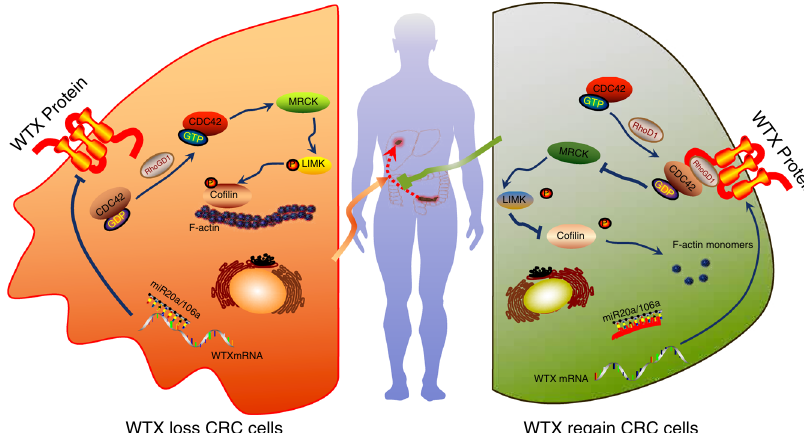
Fig. 7 The mechanism of Mir20a/106a-WTX axis regulates RhoGDI/CDC42 signaling and their function in CRC progression. In CRC cell, the aberrant high miR-20a/106a inhibits WTX expression. Without WTX, RhoGDI α could not form the stable RhoGDI α /CDC42 complex, subsequently the CDC42 GDP dissociats from RhoGDI α and transforms to CDC42 GTP and becomes active. Then CDC42 GTP activates the downstream MRCKa-LIMK1/2-Co fi lin pathway, which results in F-actin remodeling, increased cell proliferation, polarity, and migration ability, fi nally promots CRC progression and liver metastasis. To block miR-20a/106a could recover WTX expression. The regained WTX promots RhoGDI α /CDC42 complex formation and keeps it stability, so that CDC42 stays inactivity by keeping in the CDC42 GDP type which inhibits MRCKa-LIMK1/2-Co fi lin pathway, thus prevents CRC progression and liver metastasis (all the images in the fi gure are created by Q.-l. Z, polished by C. L and H.